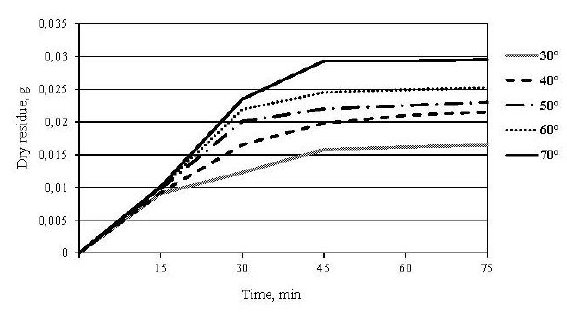
Fig. 3. Determination of the optimal temperature and time of extraction based on the dry residue